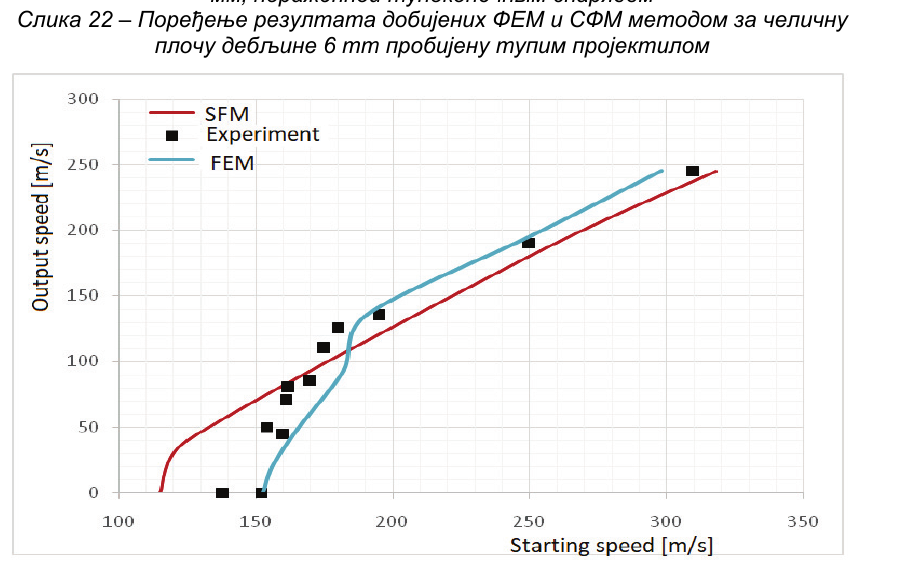
Figure 23 – Comparison of the results obtained by the FEM and SFM methods for an 8 mm thick steel plate with a blunt